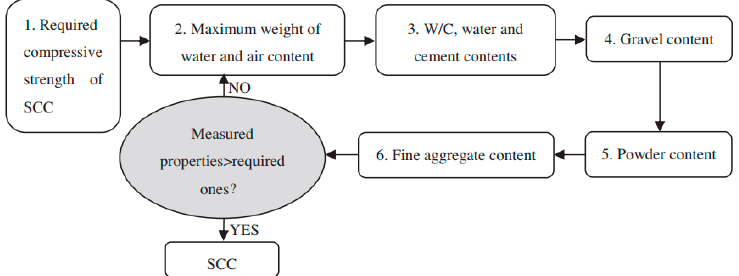
Figure 1. Mixture design procedure of method proposed by Ghazi—compressive strength method [18]. Reproduced with permission from C. Shi, Z. Wu, K. Lv and L. Wu, A review on mixture design methods for self-compacting concrete; published by Elsevier, Construction and Building Materials, 2015.